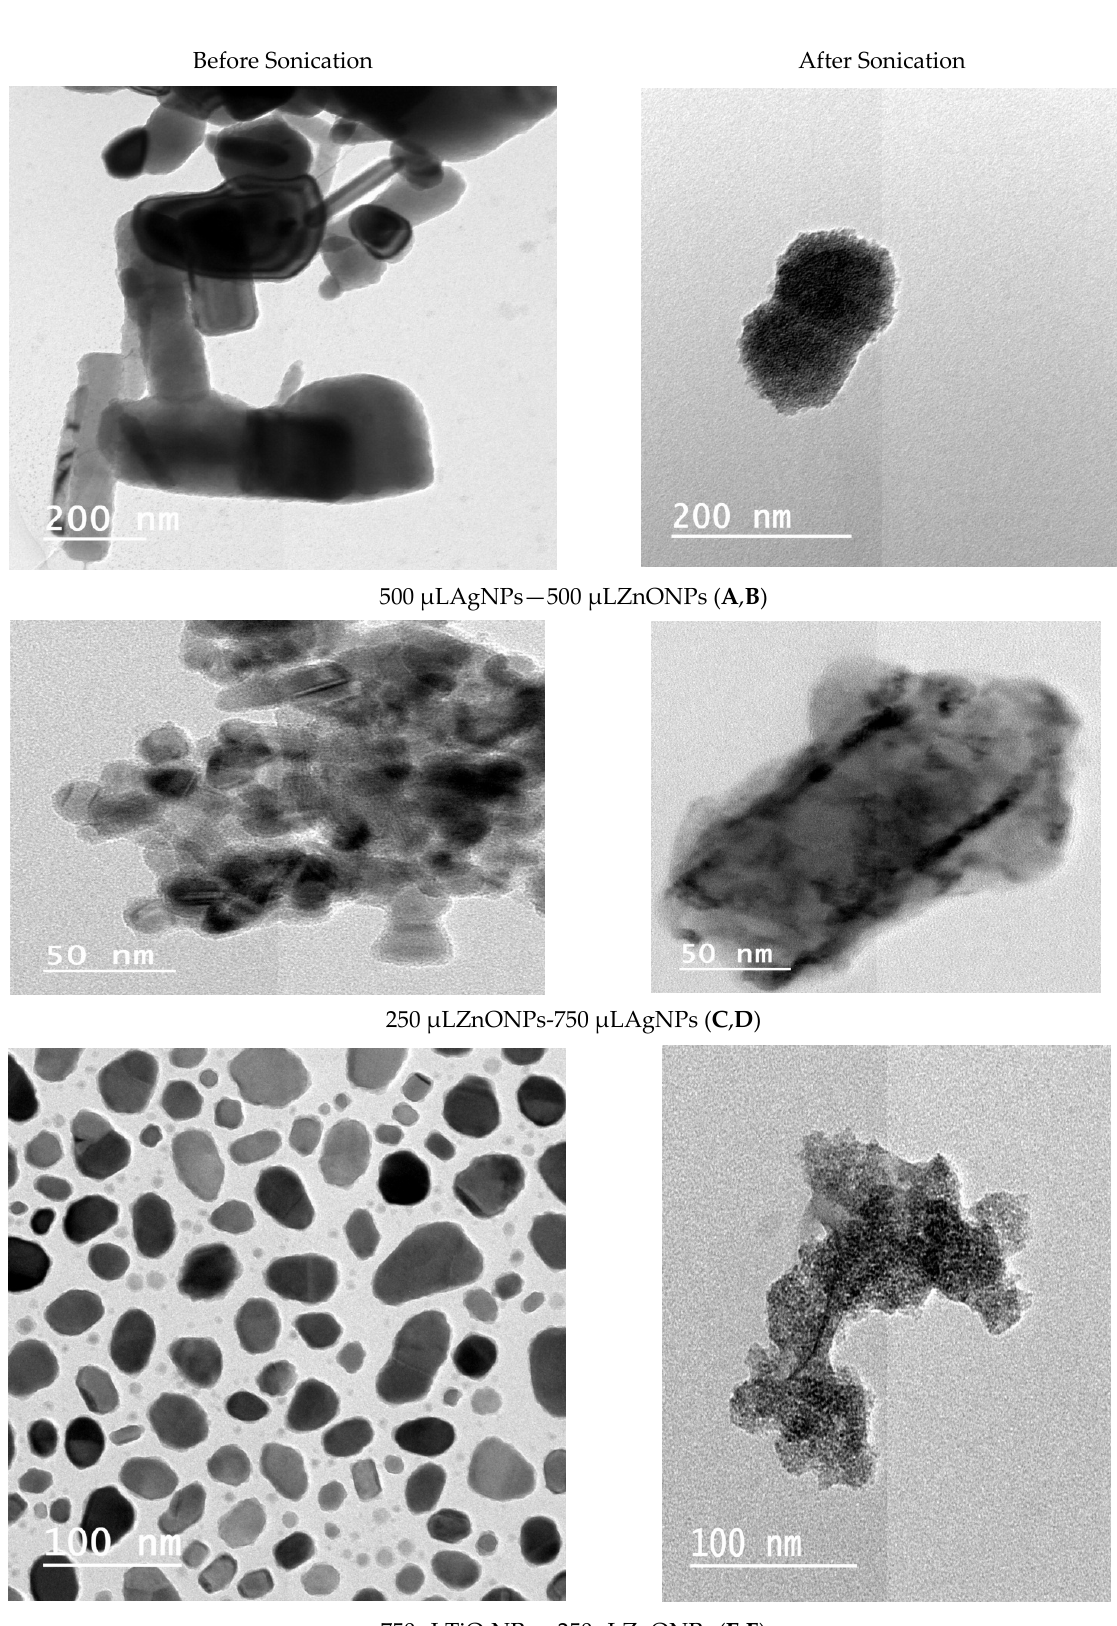
Figure 5. TEM micrograph ( A , B ) composite 500 µ L AgNPs–500 µ L ZnONPs; ( C , D ) composite 750 µ L AgNPs–250 µ L ZnO nanoparticles; ( E , F ) composite 750 µ L TiO 2 nanoparticles–250 µ L ZnO